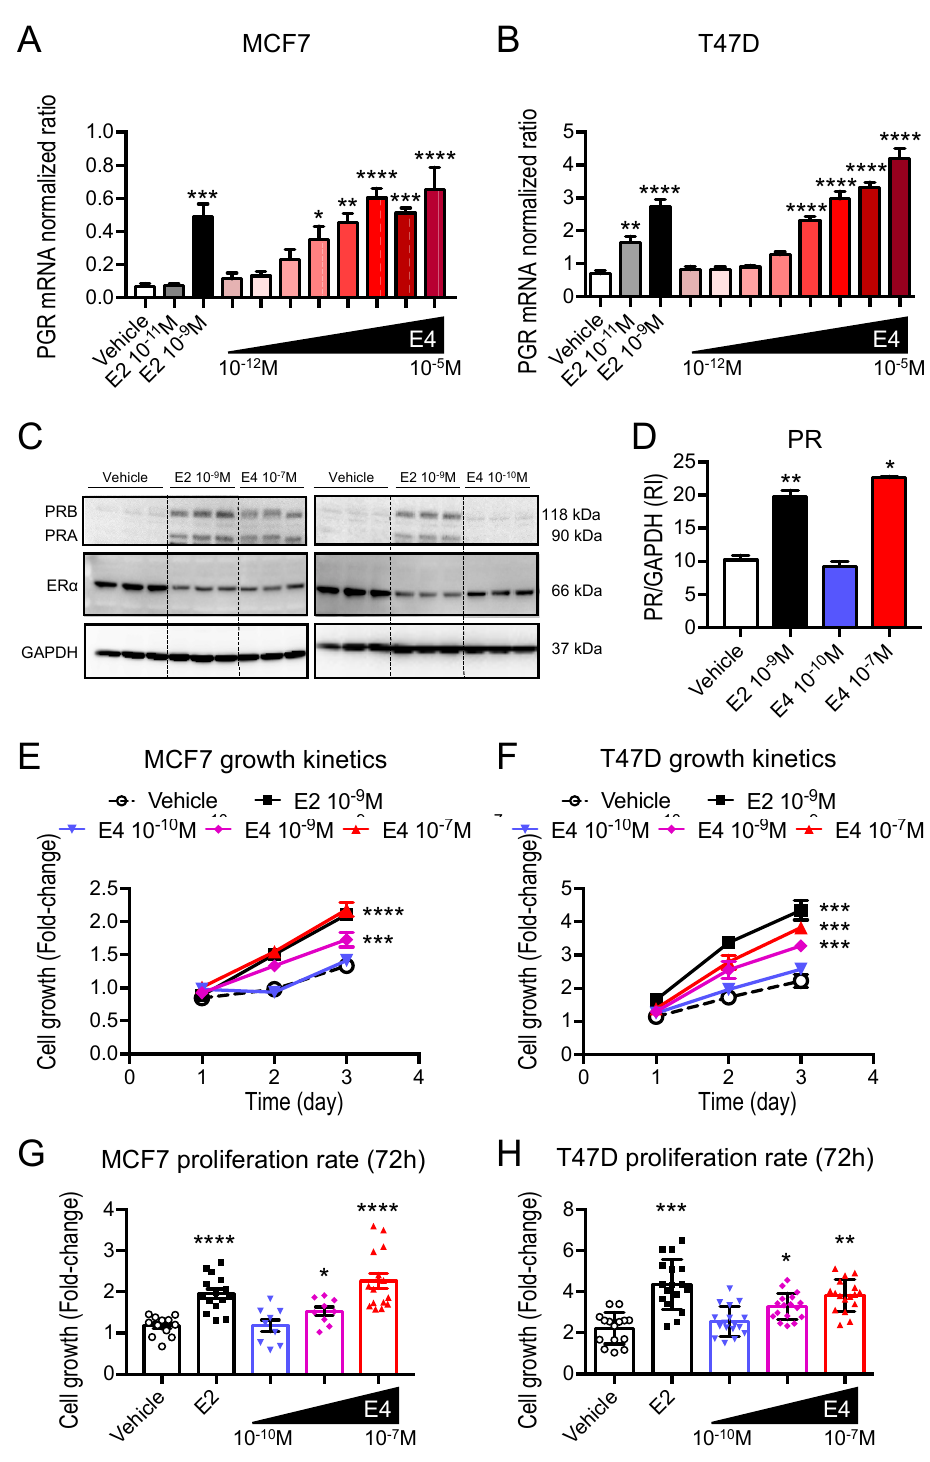
Figure 4. E4-induced ER α signaling in vitro . PGR mRNA expression normalized to TBP and GAPDH in MCF7 ( A ) and T47D cells ( B ) treated with vehicle (EtOH 0.01%), E2 (10 − 11 M or 10 − 9 M) or E4 (ranging from 10 − 12 M to 10 − 5 M) for 4 h. n = 3–4 independent experiments. One-way ANOVA analysis followed by Dunnett’s post-test. *: p < 0.05; **: p < 0.01; ***: p < 0.001; ****: p < 0.0001, * versus vehicle. ( C ) Representative Western Blot of PR (PRA and PRB) and ER α from MCF7 cells treated with vehicle (EtOH 0.01%), E2 (10 − 9 M) or E4 (10 − 7 M or 10 − 10 M) for 24h. GAPDH was used as a loading control. ( D ) Quantification of PR expression normalized to GAPDH level, RI= Relative Intensity, n = 3 independent replicates. ( E, F ) Representative experiment of cell growth kinetics of MCF7 and T47D cells treated with vehicle (EtOH 0.01%), E2 (10 − 9 M) or E4 (10 − 10 M, 10 − 9 M or 10 − 7 M).